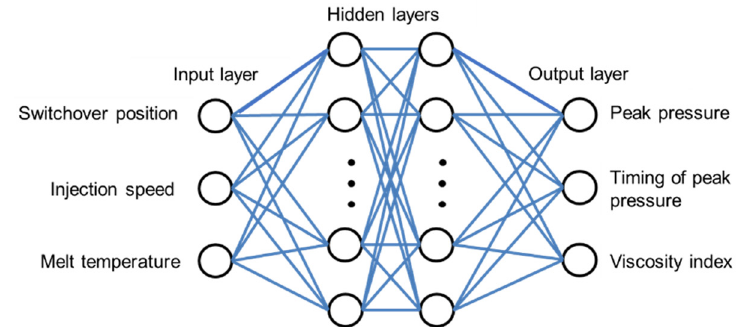
5 of 19 Figure 3. Pressure curve characteristics. 2.4. Back Propagation Neural Network(BPNN)